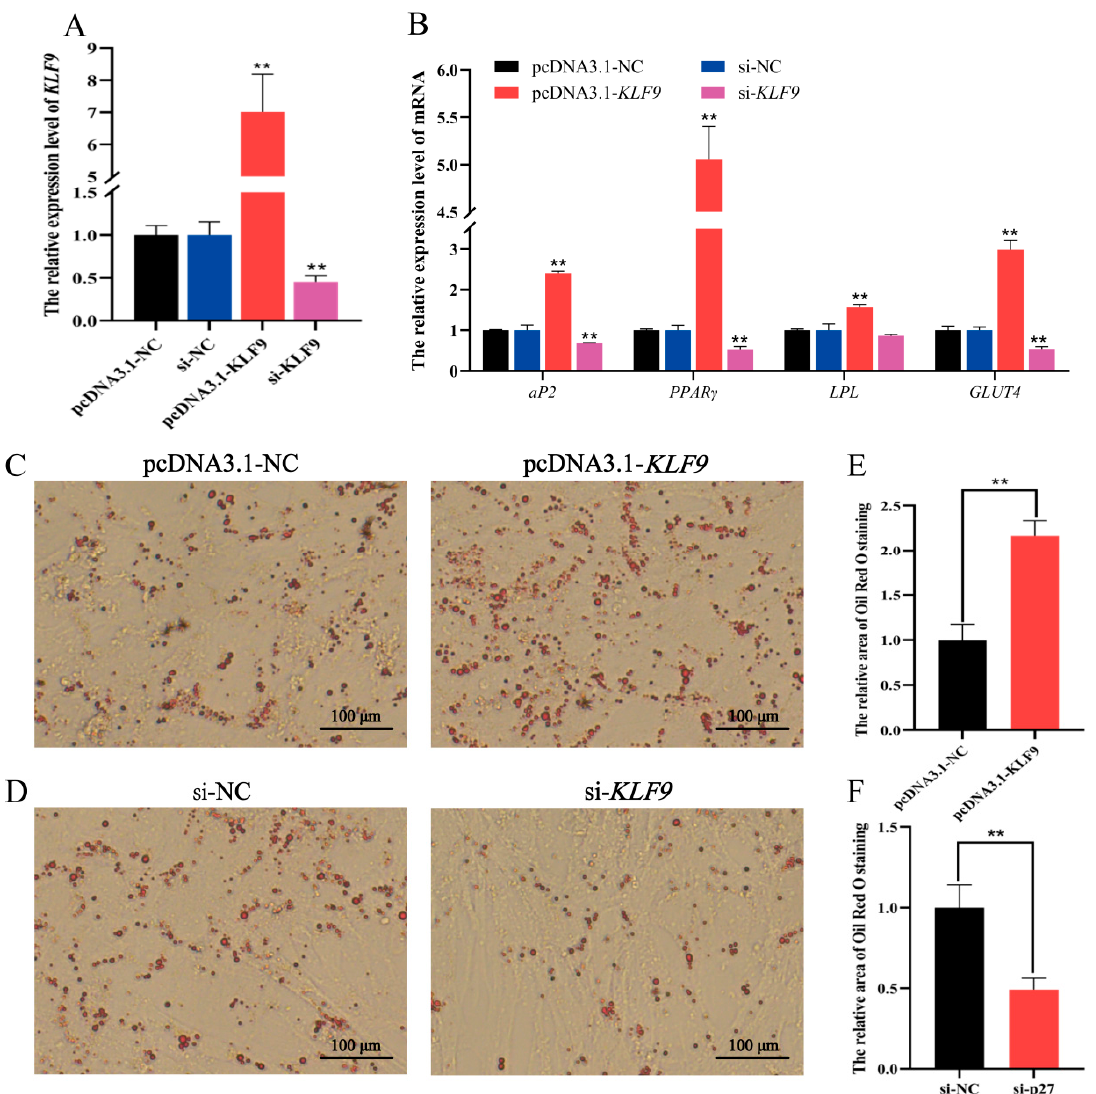
Figure 8. The effect of KLF9 on ovine adipocyte differentiation when pcDNA3.1 ‐ KLF9 , si ‐ KLF9 and their NC were transfected into differentiated preadipocytes. ( A ) The expression level of KLF9 . ( B ) The expression levels of aP2 , PPAR γ , LPL and GLUT4 . ( C , D ) The Oil Red O staining results. ( E , F ) The relative area of Oil Red O staining was counted using the ImageJ software. The values represent mean ± SD ( n = 3), ** p < 0.01.